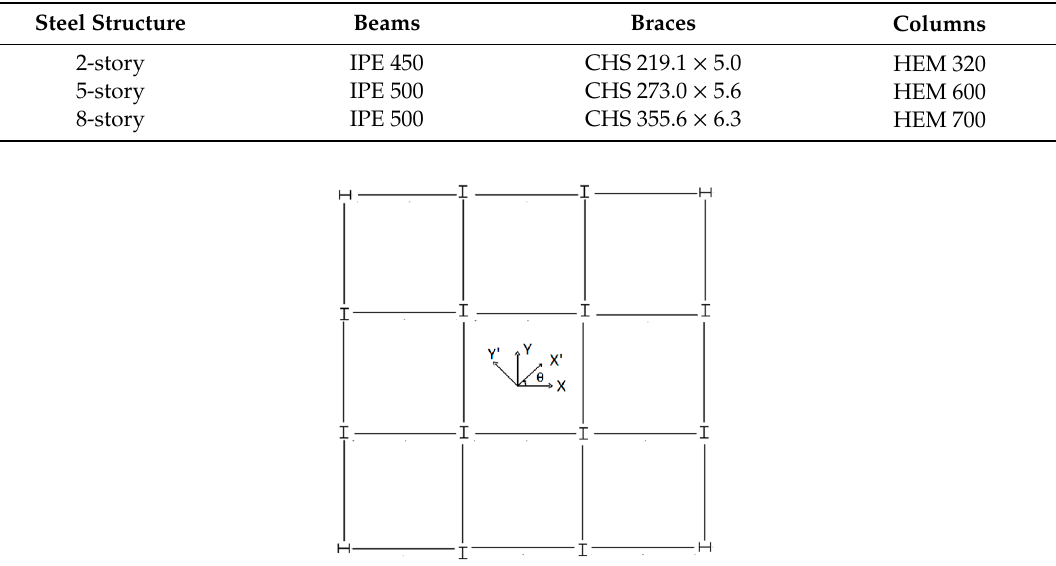
Figure 1. Two-, five-, and eight-story steel buildings. Figure 1. Two ‐ , five ‐ , and eight ‐ story steel buildings. Table 1. Sections of steel beams, braces, and columns.